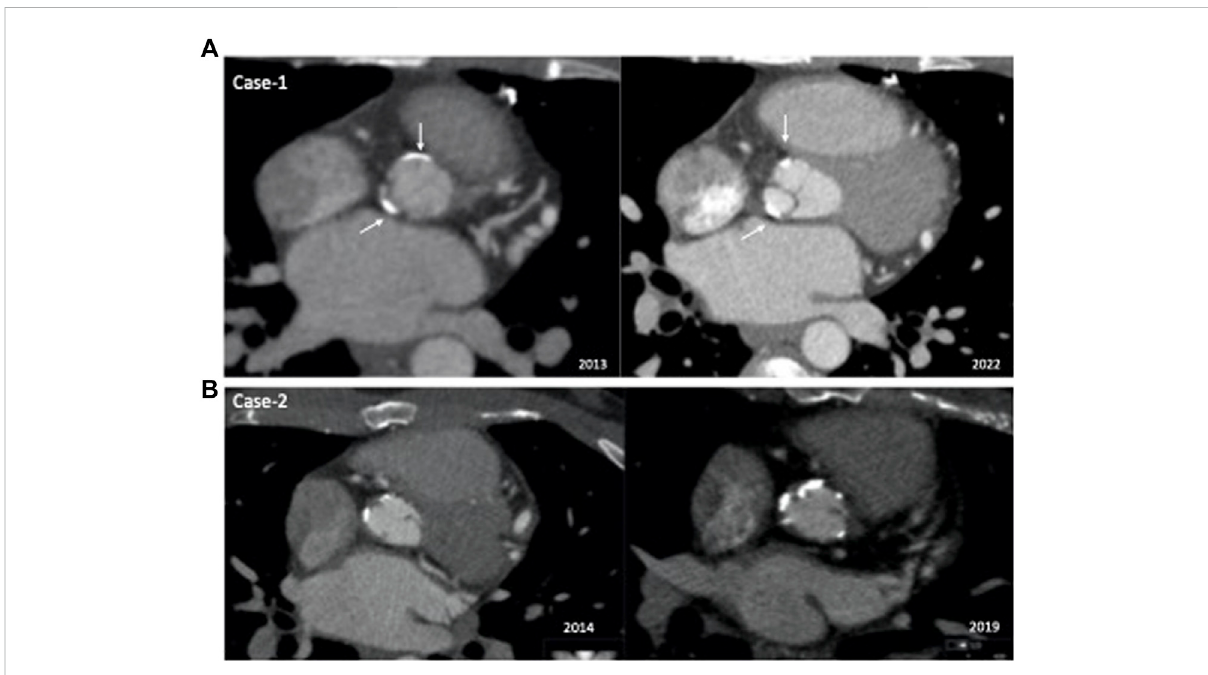
FIGURE 2 Comparison of baseline and follow-up computed tomography angiography images of the patients. (A) Case 1: Aortal involvement was almost identical between the baseline (2013) and follow-up (2022) images. (B) Case 2: Comparison of 2014 and 2019 − ΔΔ CT angiograms showed signi fi cant progression of calci fi cations in the aortic